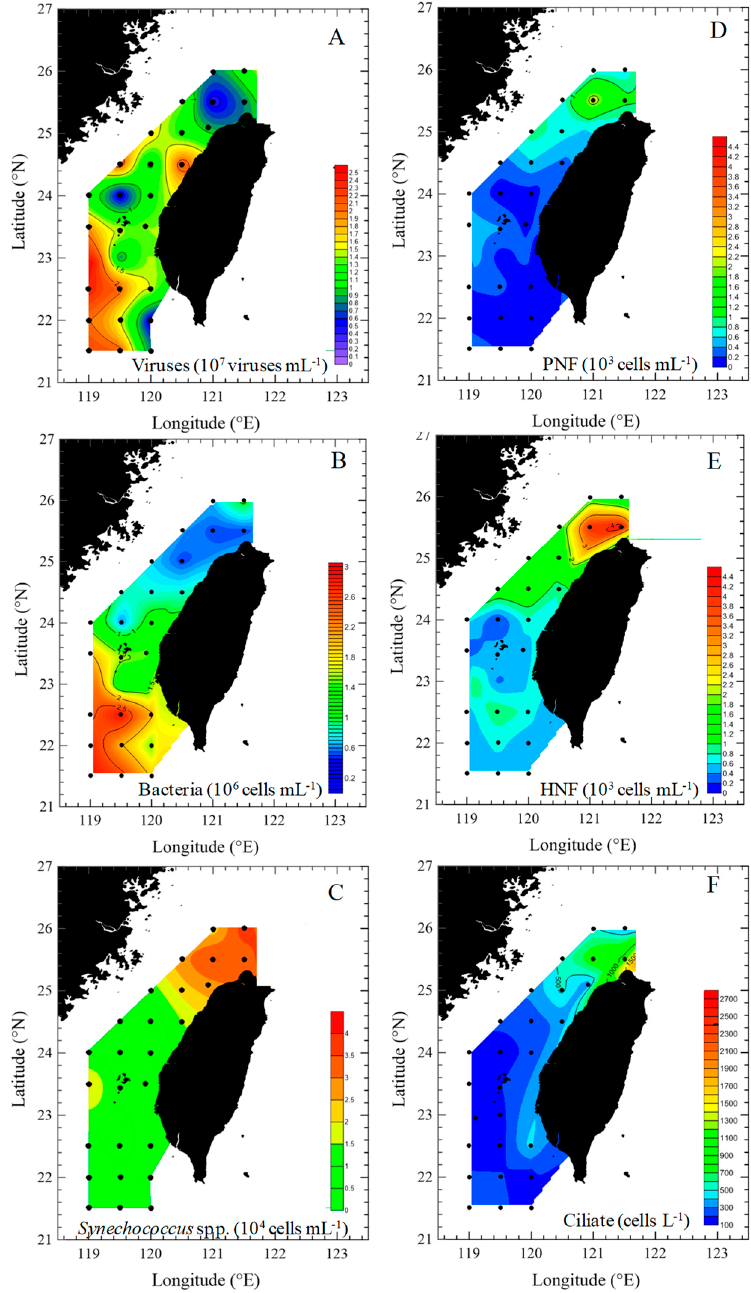
Figure 3. Spatial variations of viral ( A ), bacterial ( B ), Synechococcus spp. ( C ), heterotrophic nanoflagellate ( D ), pigmented nanoflagellate ( E ), and ciliate ( F ) abundance during the study period in Taiwan Strait.